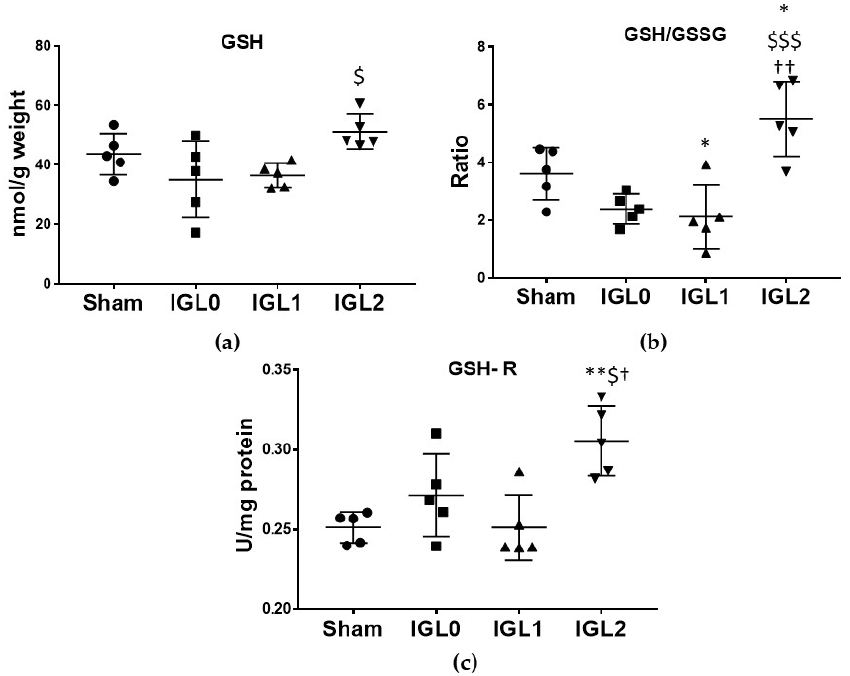
Figure 7. Glutathione status in steatotic livers preserved (4 °C, 24 h) in the IGL-0, IGL-1, and IGL-2 solutions vs. Sham: ( a ) reduced glutathione (GSH) expressed in nmol GSH/g fresh weight; ( b ) reduced glutathione/oxidized glutathione ratio (GSH/GSSG); ( c ) glutathione reductase (GSH-R) expressed in mU/mg of protein. The bars represent the mean values ± SDs of each group. Differences are shown comparing groups (* vs. Sham, $ vs. IGL-0, and † vs. IGL-1) according to the one-way ANOVA test and the Tukey post-hoc test (one symbol indicates p < 0.05; two symbols indicate p < 0.01; three symbols indicate p < 0.001).